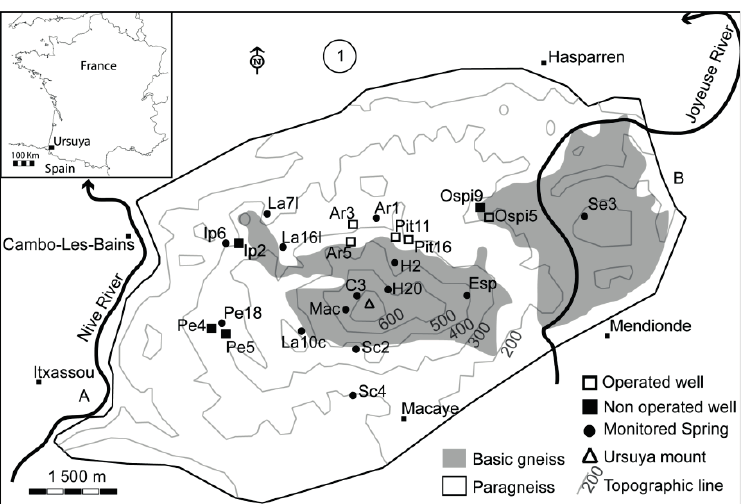
Fig. 1 Ursuya Mount topography and localisation of the sampling